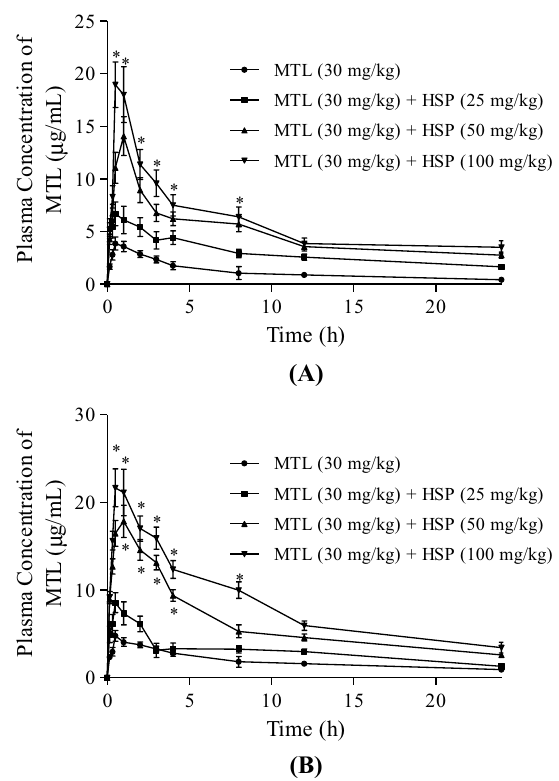
Fig. 2 Metoprolol mean plasma concentration–time curves after oral administration of 30 mg/kg metoprolol with or without hesperetin A on day 1; B on day 15. * p < 0.001 compared to metoprolol